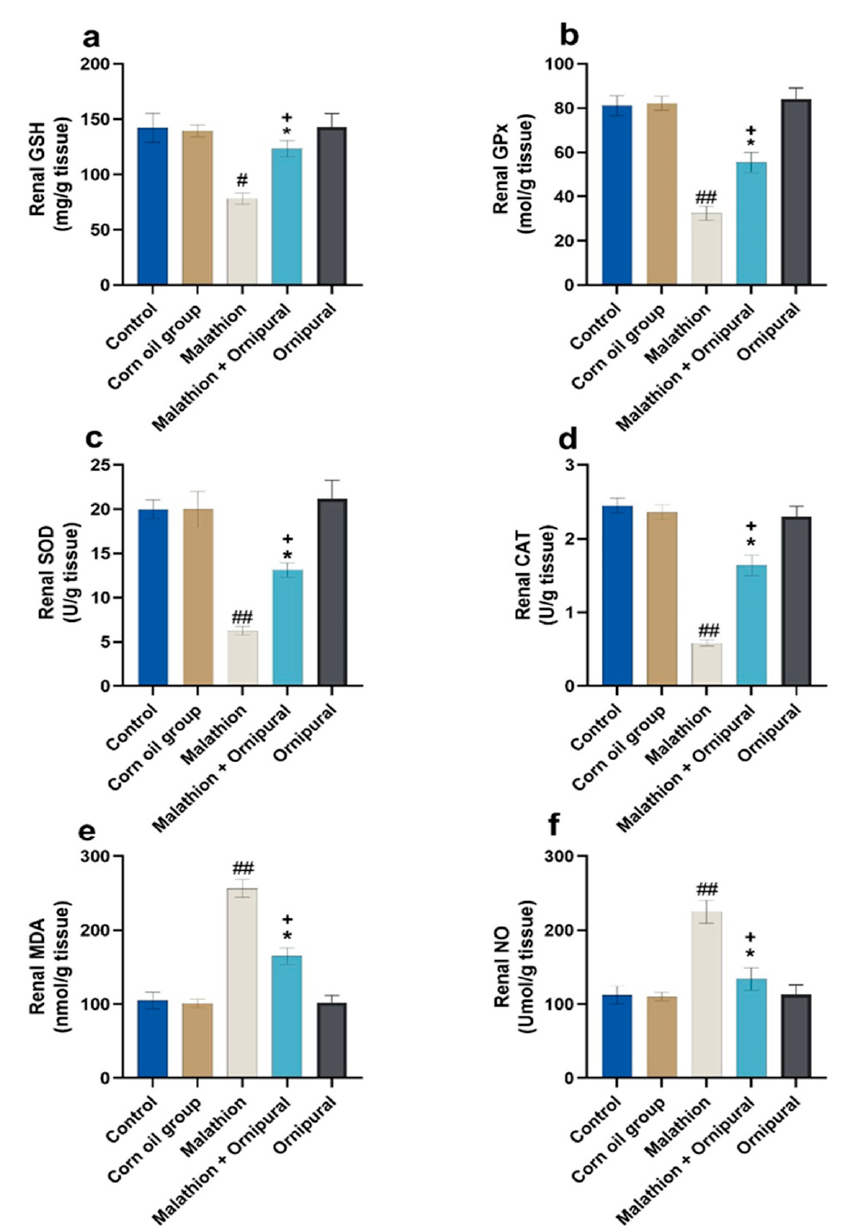
Figure 2. Modulatory effect of Ornipural ® against malathion-induced oxidative stress in renal tissue ( a ) G.S.H. ( b ) G.P.X. ( c ) S.O.D. ( d ) C.A.T. ( e ) M.D.A. ( f ) NO. The statistical analysis was performed